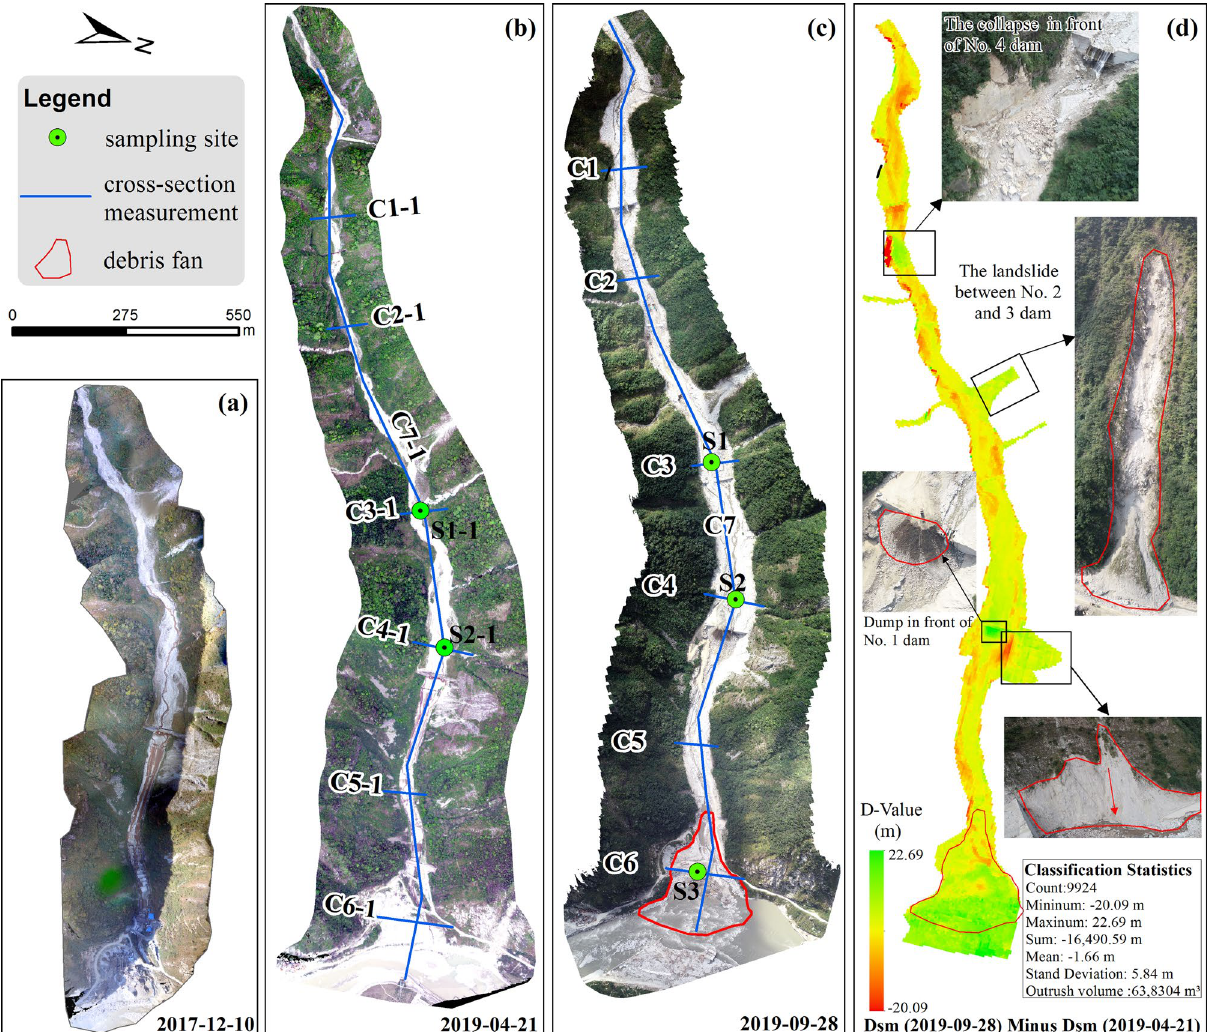
Figure 4. Field investigation sketch map. ( a ) Drone image taken on Dec. 10, 2017; ( b ) Drone image taken on Apr. 21, 2019, the distribution of sampling sites and cross (longitudinal)-section map are also noted; ( c ) Drone image taken on Sep. 28, 2019, the distribution of sampling sites and cross (longitudinal)-section map are also noted; ( d ) Raster image obtained by subtracting the DSM of April 21, 2019 from the DSM of September 28, 2019.Maps constructed using ArcGIS 10.2 (https:// deskt op. arcgis. com/